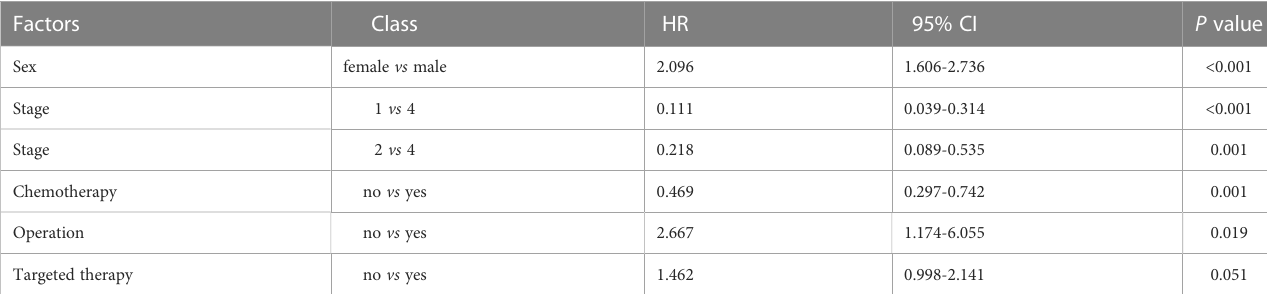
TABLE 2 Multivariate analysis of survival factors in lung cancer by COX proportional hazards regression